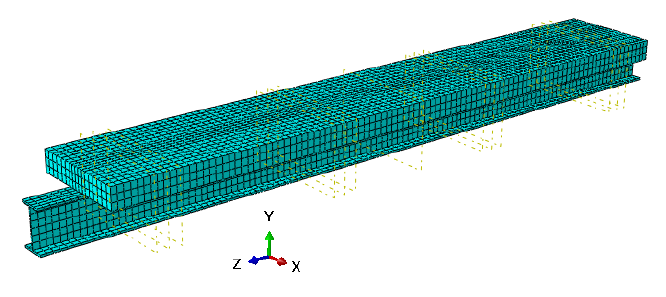
Figure 3. Finite element